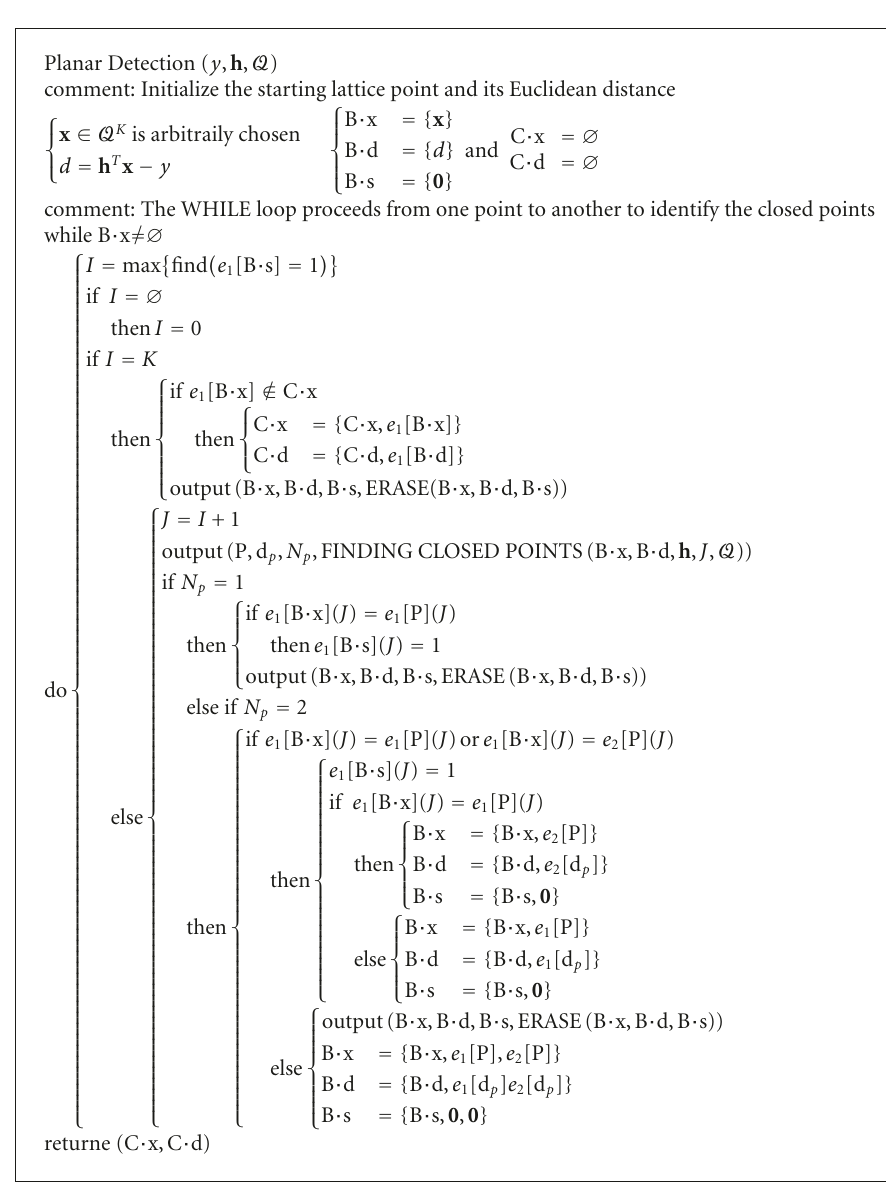
Algorithm 1: The pseudocode of the Planar Detection algorithm where ∅ is an empty set, e i [A] denotes the i th element of a given set A, and e i [A]( j ) denotes the j th entry of the i th element of A. The algorithms of finding closed points and erase are shown in Algorithms 2 and 3,